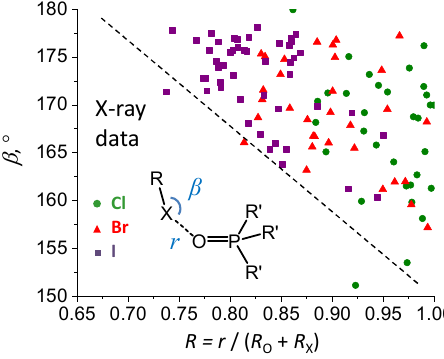
Figure 3. Correlation between angles β (R–X ··· O) and normalized distance parameter R = r / ( R O + R X ), where r is X ··· O distance and R O and R X are van der Waals radii of oxygen and halogen atoms, respectively, for CCDC 2020 structures containing R–X ··· O = P fragment (X = Cl, Br, I). For the complete list of entries see Table S3.